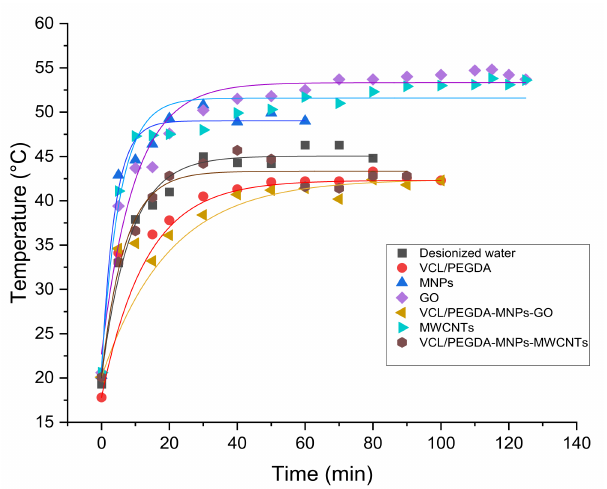
Figure 7. Thermal studies. deionized water (control black line), VCL/PEGDA (red line), MNPs (blue line), GO (violet line), MWCNTs (light blue line), VCL/PEGDA-MNPs-GO (yellow line) and VCL/PEGDA-MNPs-MWCNTs (brown line). GO = 3.47 µ g · mL − 1 , MWCNTs = 3.47 µ g · mL − 1 , MNPs = 93.3 µ g · mL − 1